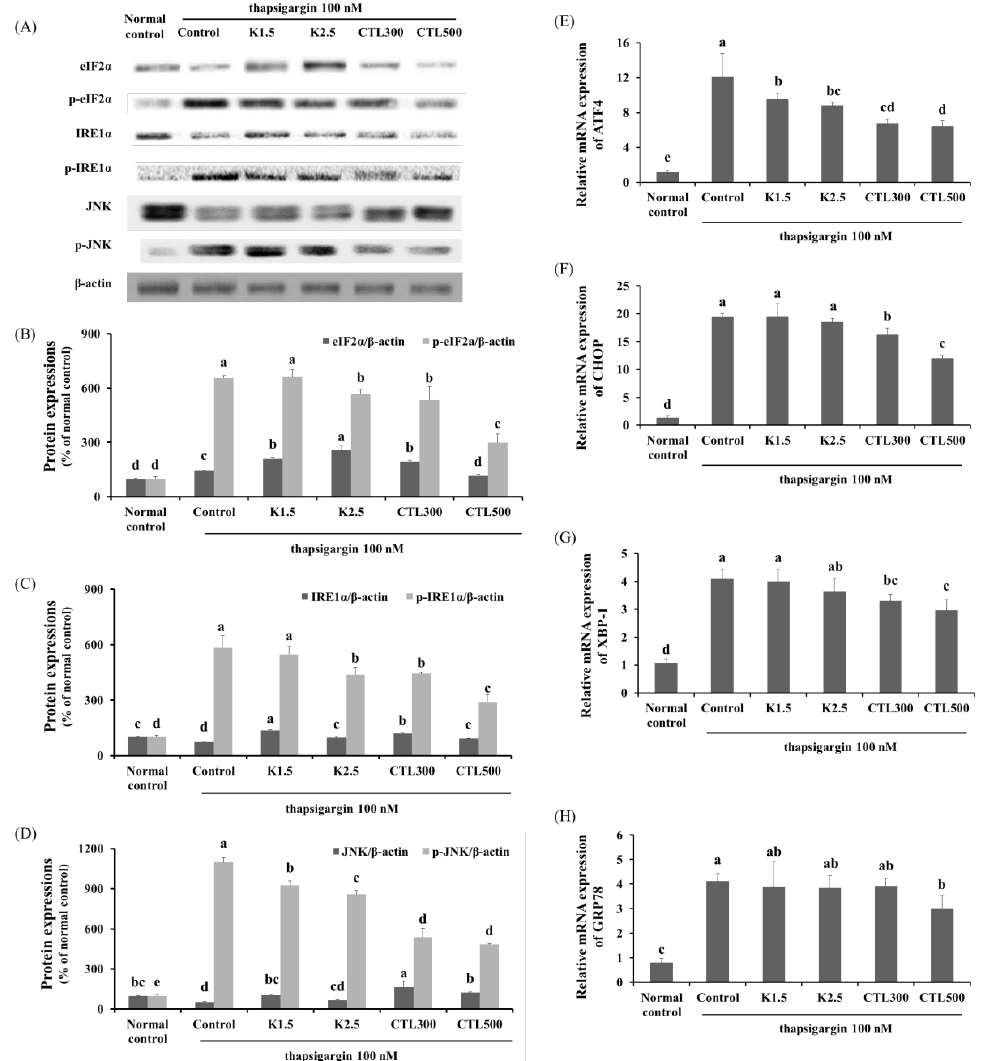
Figure 3. Effect of CTL and kaempferol (K) on ER stress in thapsigargin-induced HepG2 cells. ( A ) Representative Western blots for total protein and phosphorylation of eIF2α, IRE-1α and JNK in thapsigargin-induced HepG2 cells with CT water extract or kaempferol; ( B ) densitometric analysis of the phosphorylation of eIF2α, ( C ) IRE-1α and ( D ) JNK; mRNA expression of ( E ) ATF4, ( F ) CHOP, ( G ) XBP-1 and ( H ) GRP78 in thapsigargin-induced HepG2 cells with CT water extract or kaempferol.